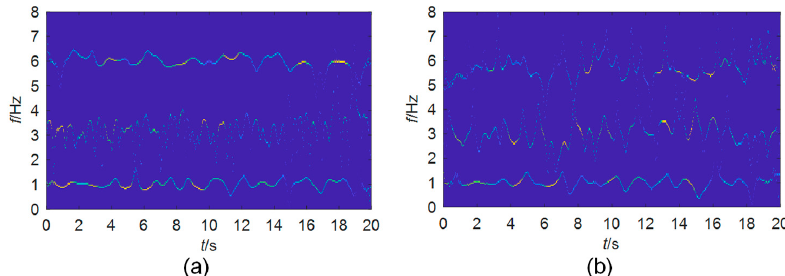
Figure 6. TF planes of mono-components extracted from the simulated signals with an SNR of: ( a ) − 6 dB; ( b ) − 10 dB.